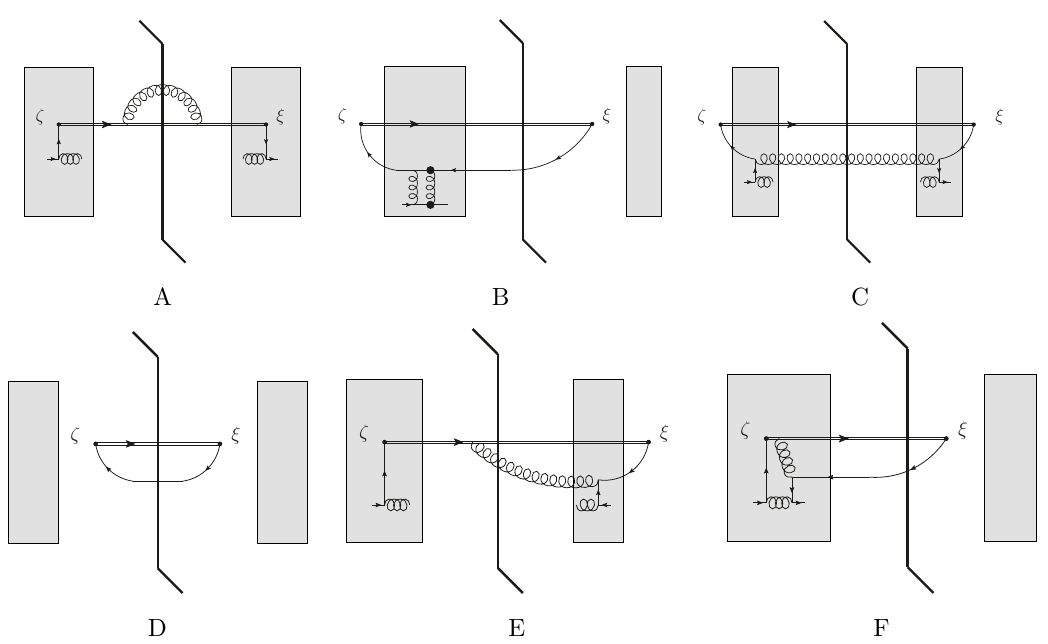
Figure 5. Diagram classes of [1] contributing to a calculation of a quark TMD. The double lines represent the fundamental Wilson lines, the shaded rectangles represent the proton shockwave, the black circles in B represent the sub-eikonal scattering which brings in transverse spin dependence, and the thick vertical line represents the final state